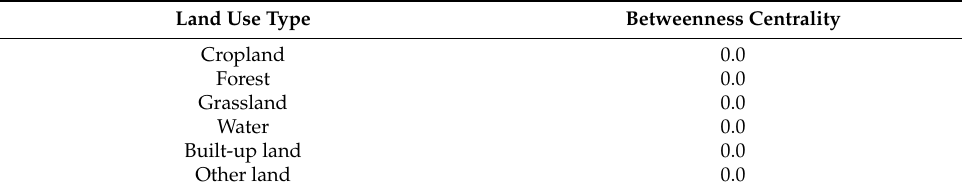
Table 11. The Betweenness Centrality of land use change from 2015–2030.